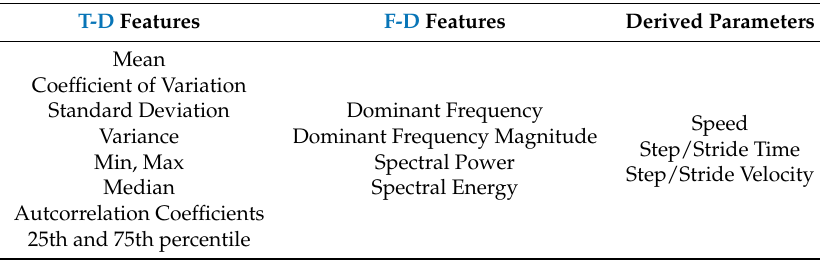
Table 3. Details of the features mostly selected to feed activity classifiers according to their associated categories (T-D Features, F-D Features, and derived